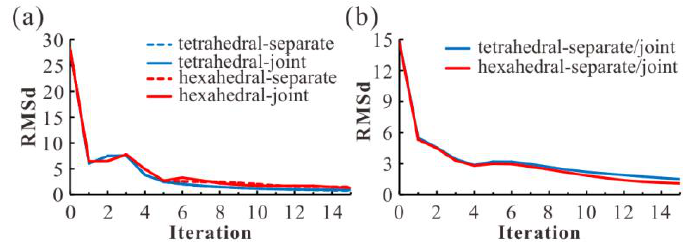
Figure 12. RMSd of inversion. ( a ) RMSd of gravity; ( b ) RMSd of magnetic.